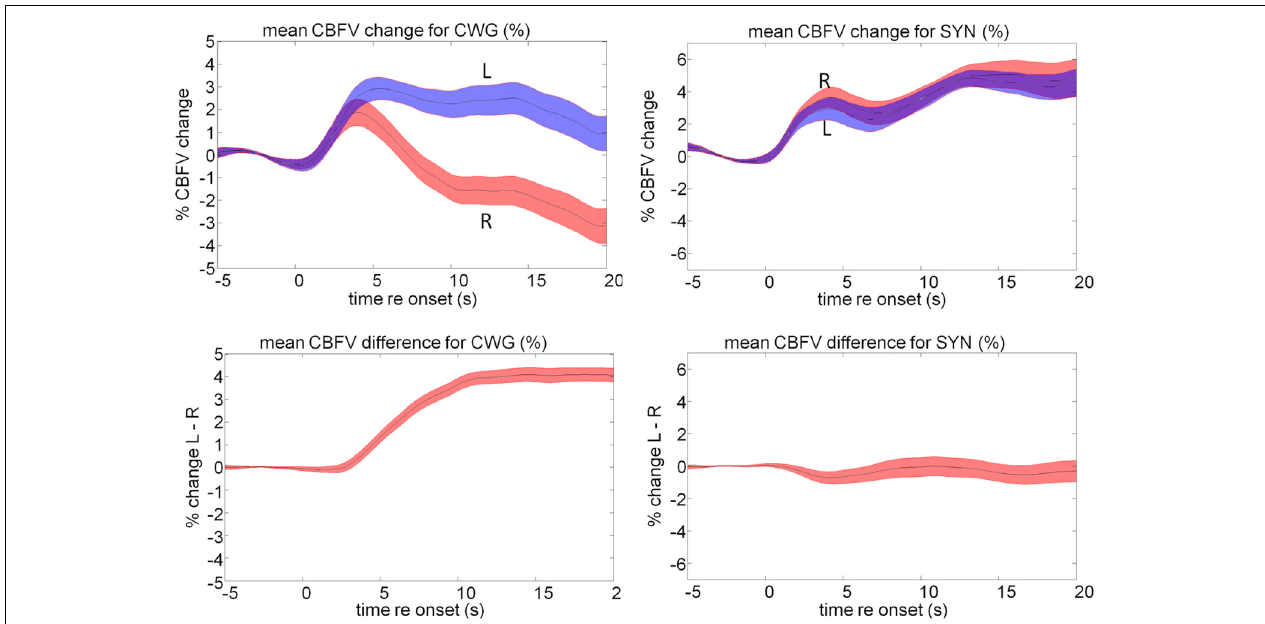
FIGURE 10 | Mean cerebral blood flow changes (top) and lateralization pattern for the cued word generation (CWG) and music synthesis (SYN) tasks. The shaded area defines the standard